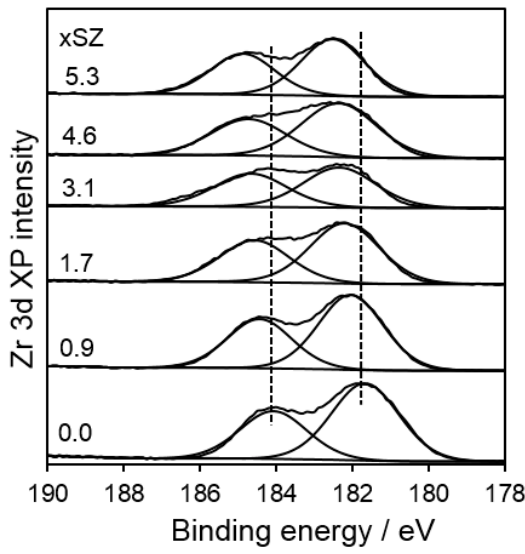
Figure 3. Zr 3d XP spectra of parent and sulfated zirconia as a function of bulk S loading.